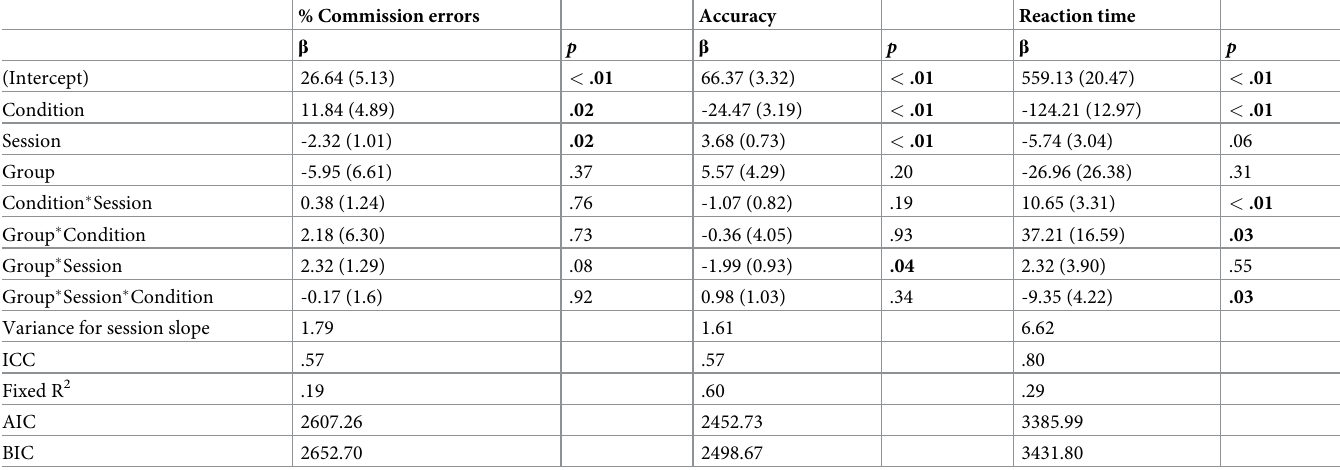
Table 3. Full MLMs for behavioral measures from Go-NoGo shooting task.